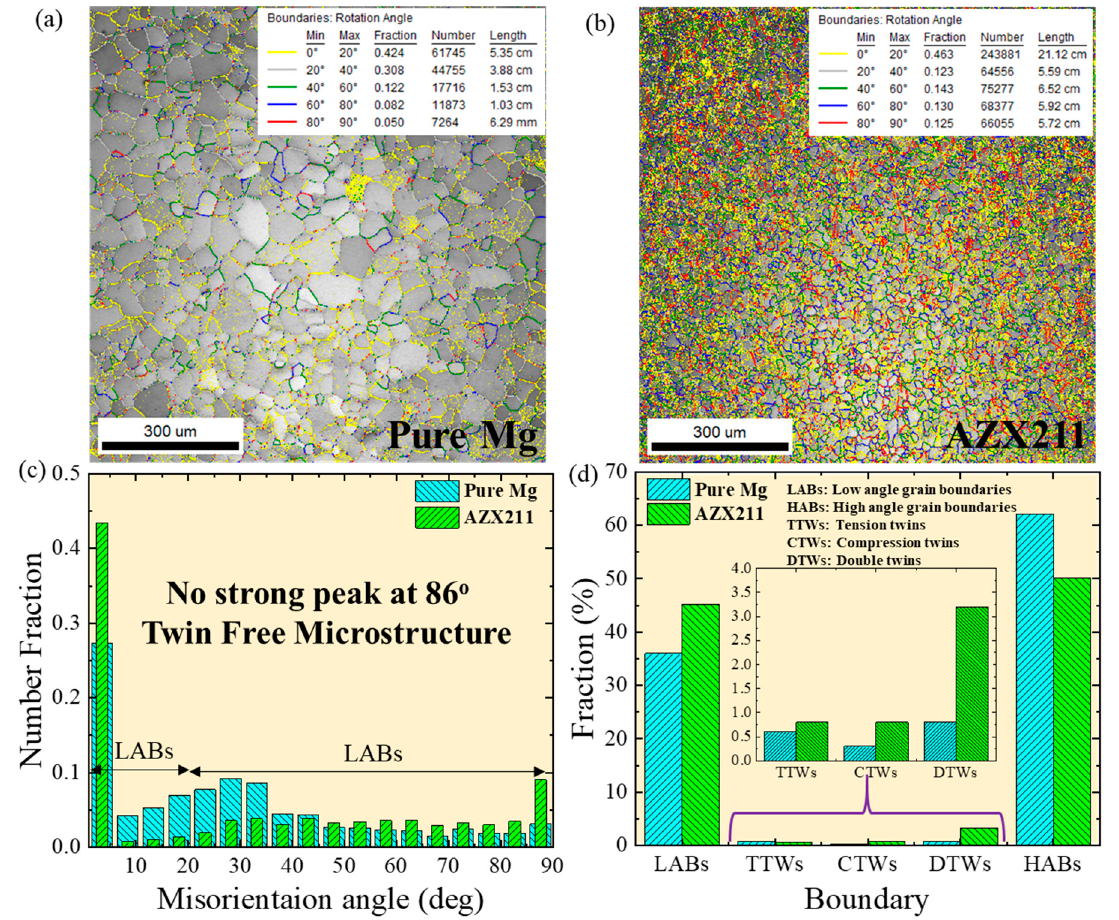
Figure 6. Image quality maps superimposed with the grain boundaries rotational angles for ( a ) pure Mg, ( b ) AZX211, ( c ) and ( d ) Misorientation distribution profiles for both samples.